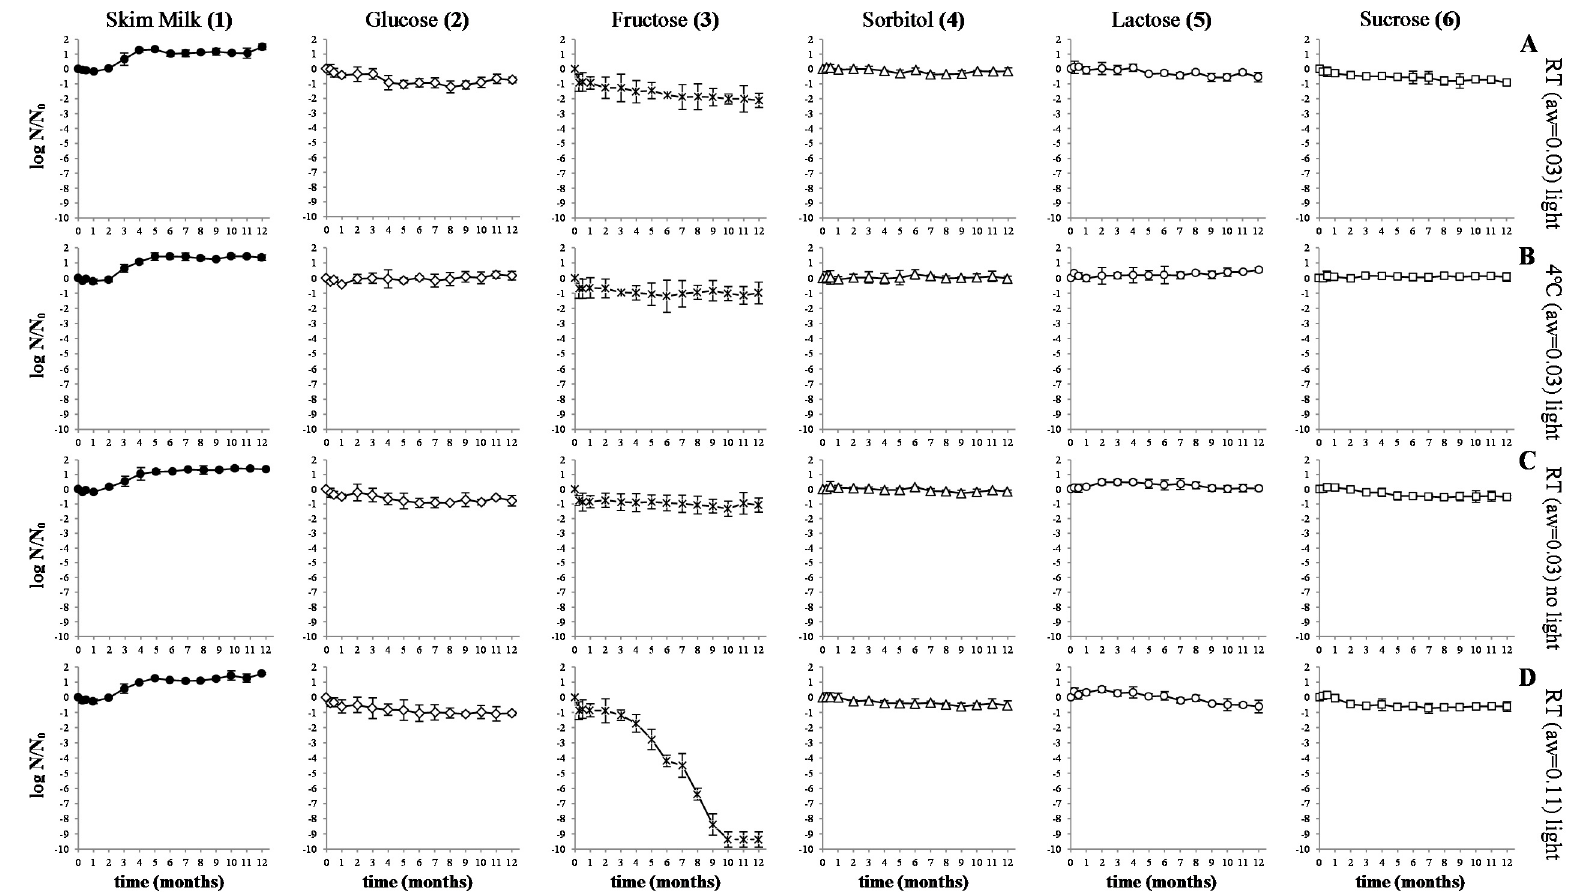
Figure 2. Logarithmic reduction of P. acidilactici HA ‐ 6111 ‐ 2 incorporated in RSM or orange juice with 2% of 10 DE maltodextrin after spray drying and during 12 months of storage at different storage conditions ( A – D ): control (inoculum in 10% ( w / v ) of RSM); inoculum in orange juice with 2% of 10 DE maltodextrin after grown in MRS supplemented with 20 g/L of different sugars (2, 3, 4, 5 and 6). The dotted lines mean that survival was lower than the detection limit of the enumeration technique.